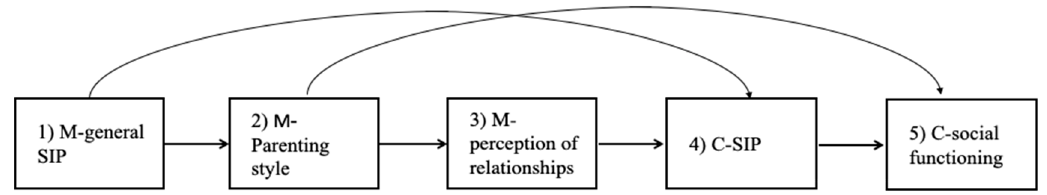
Figure 2. The study’s conceptual model.